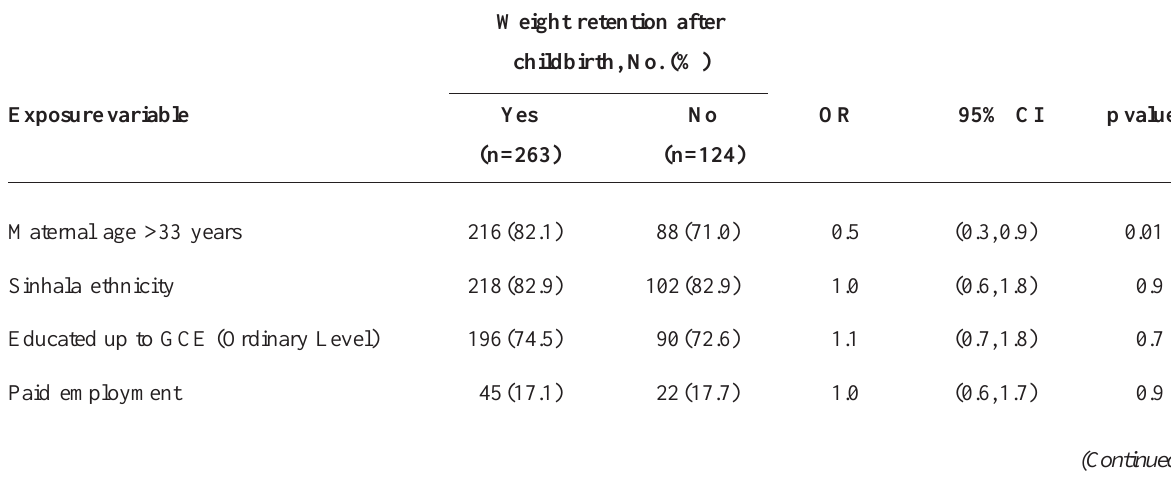
Table 1. Unadjusted odds ratios for the association with weight retention at six months after childbirth and independent